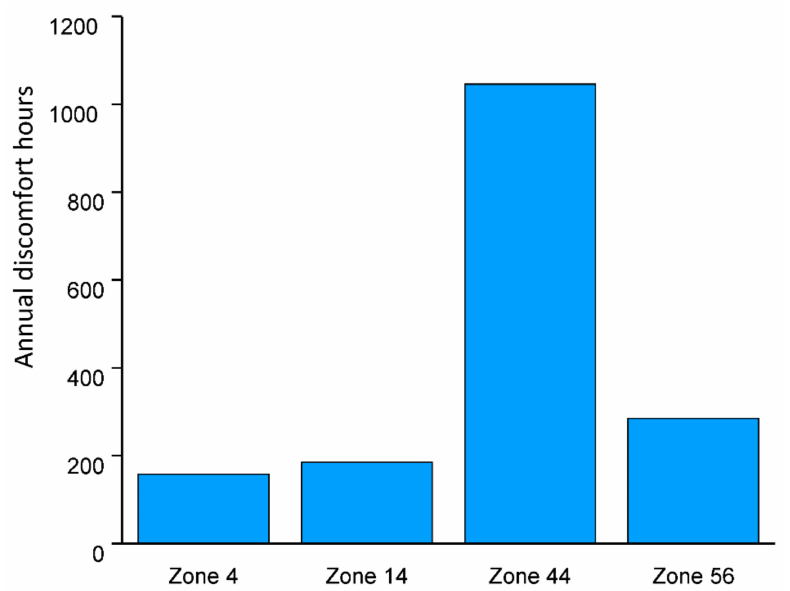
Figure 20. Number of annual discomfort hours during occupancy time based on EN 16798-1 comfort categories in case B (with low-E film).